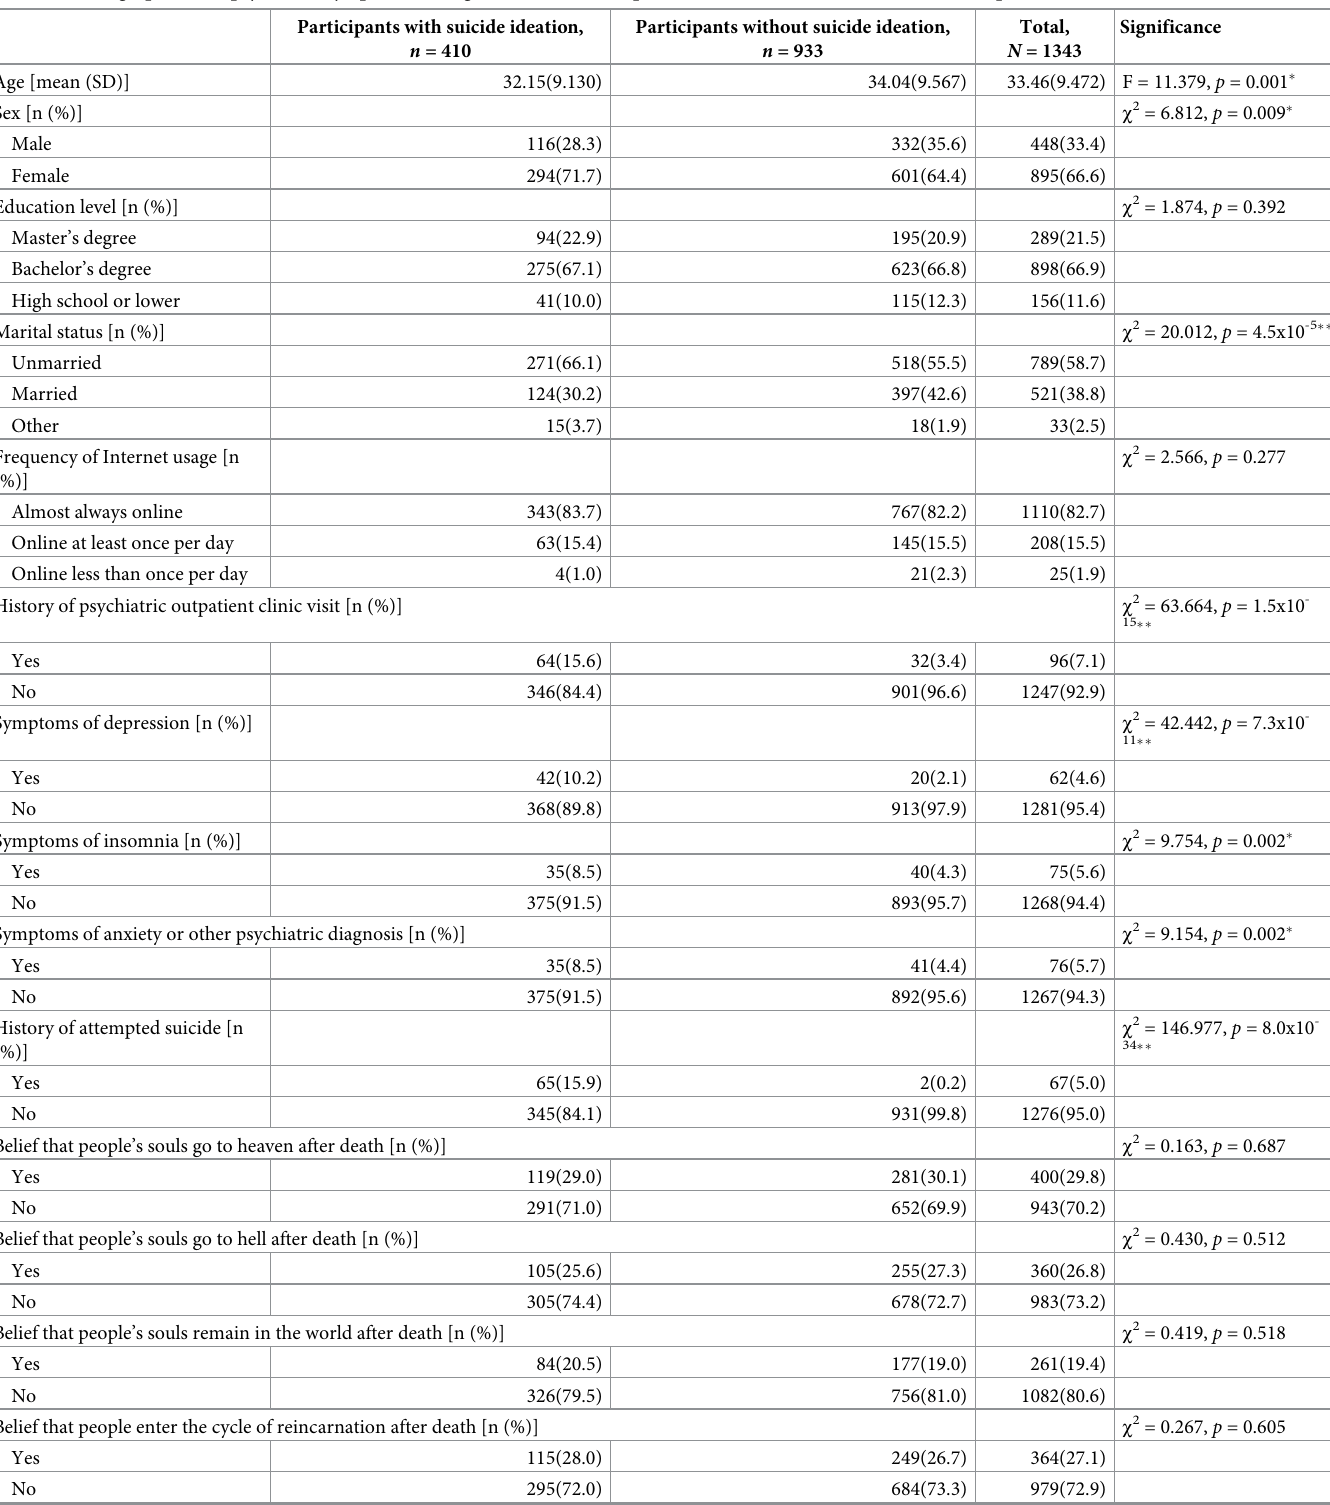
Table 1. Demographic data, psychiatric symptoms during lifetime, and conceptualisation of life after death in relation to presence of suicide